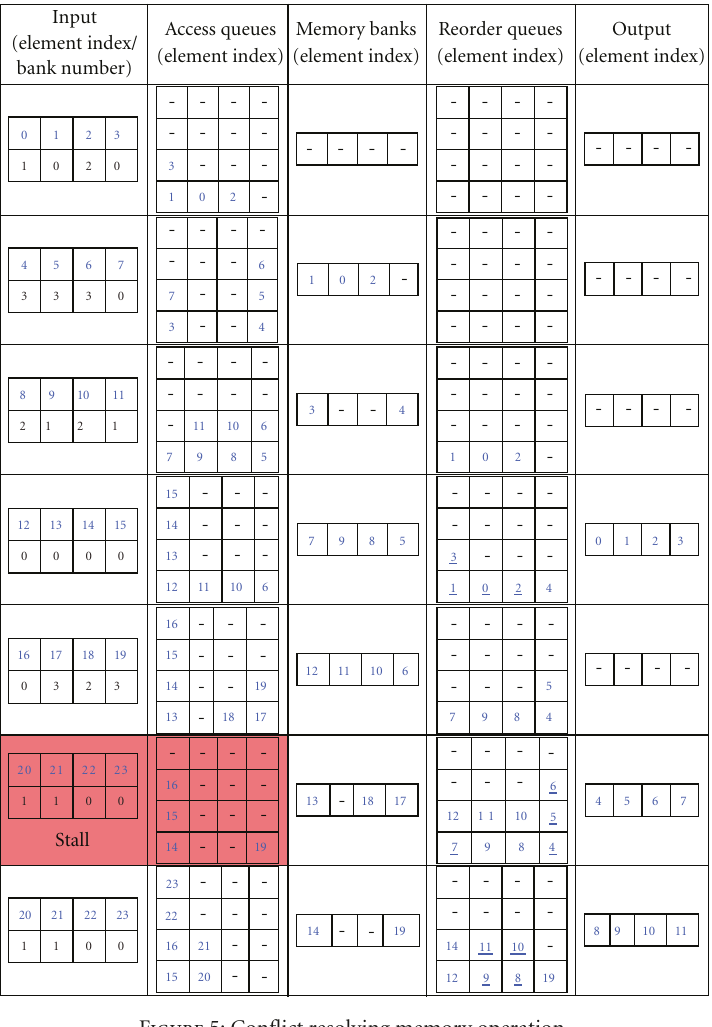
Figure 5: Conflict resolving memory operation.